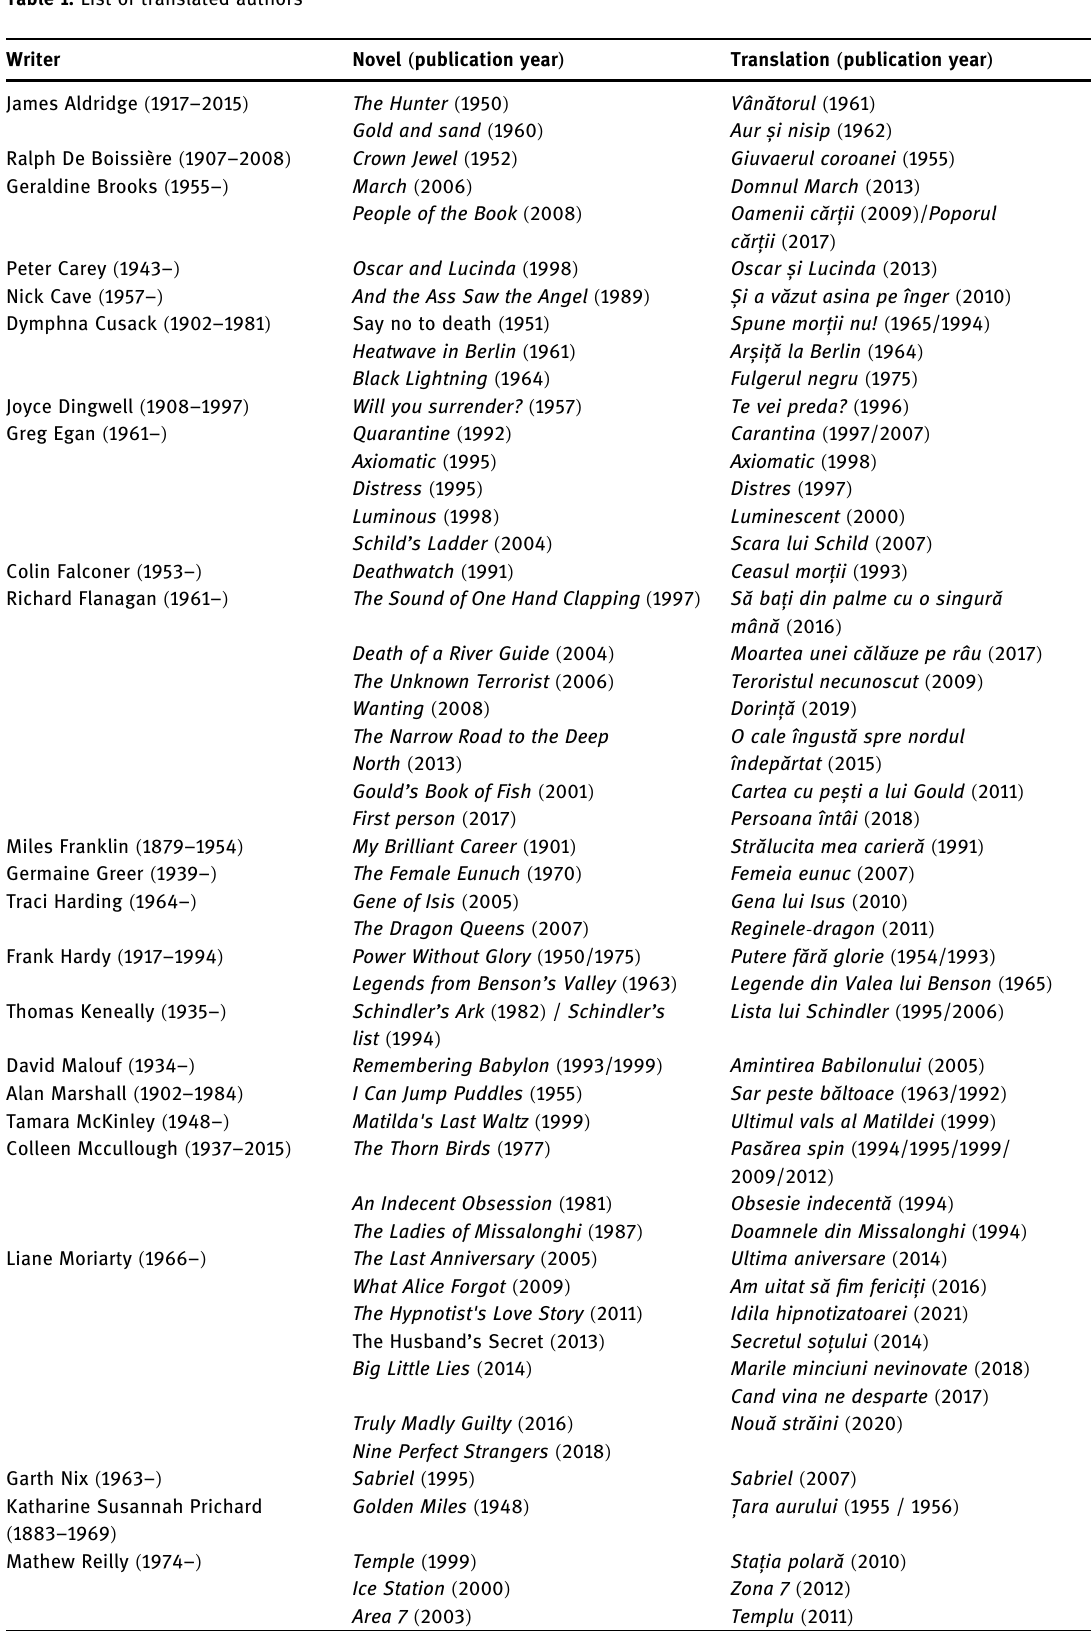
Table 1: List of translated